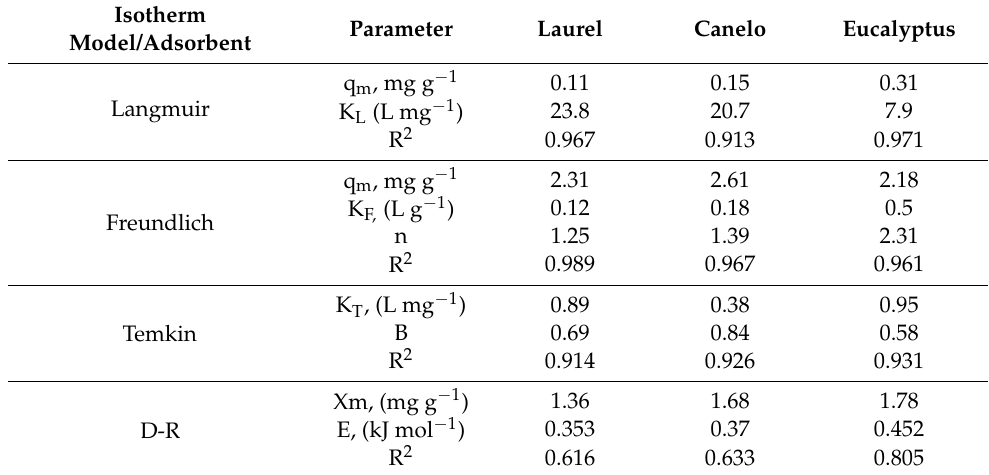
Table 3. Linear adsorption isotherm fitting parameters on magnetic